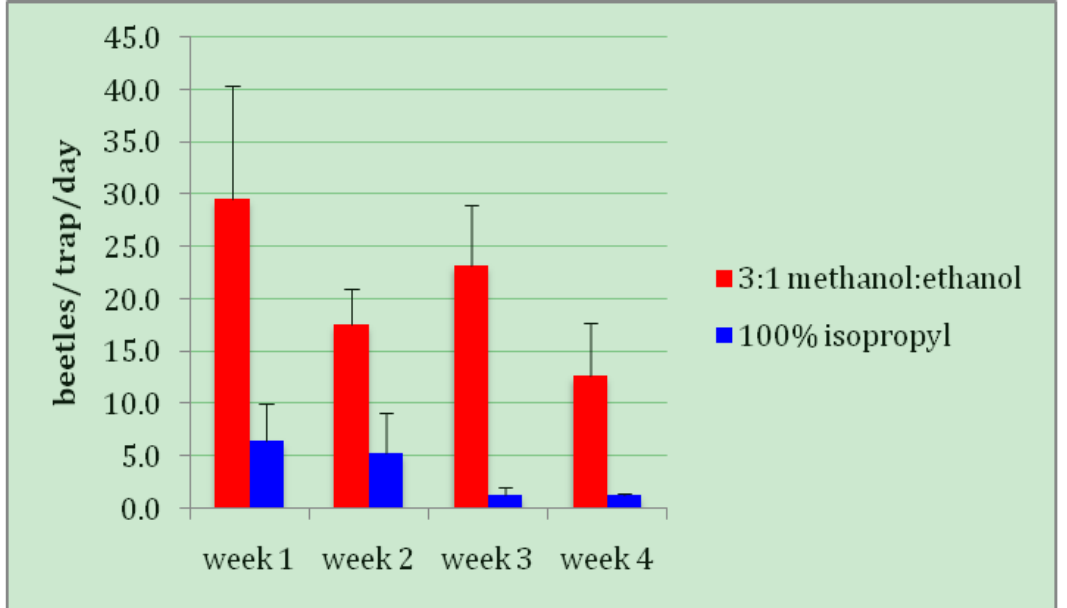
Figure 4. Trap captures of adult coffee berry borers: isopropyl alcohol vs. methanol: ethanol